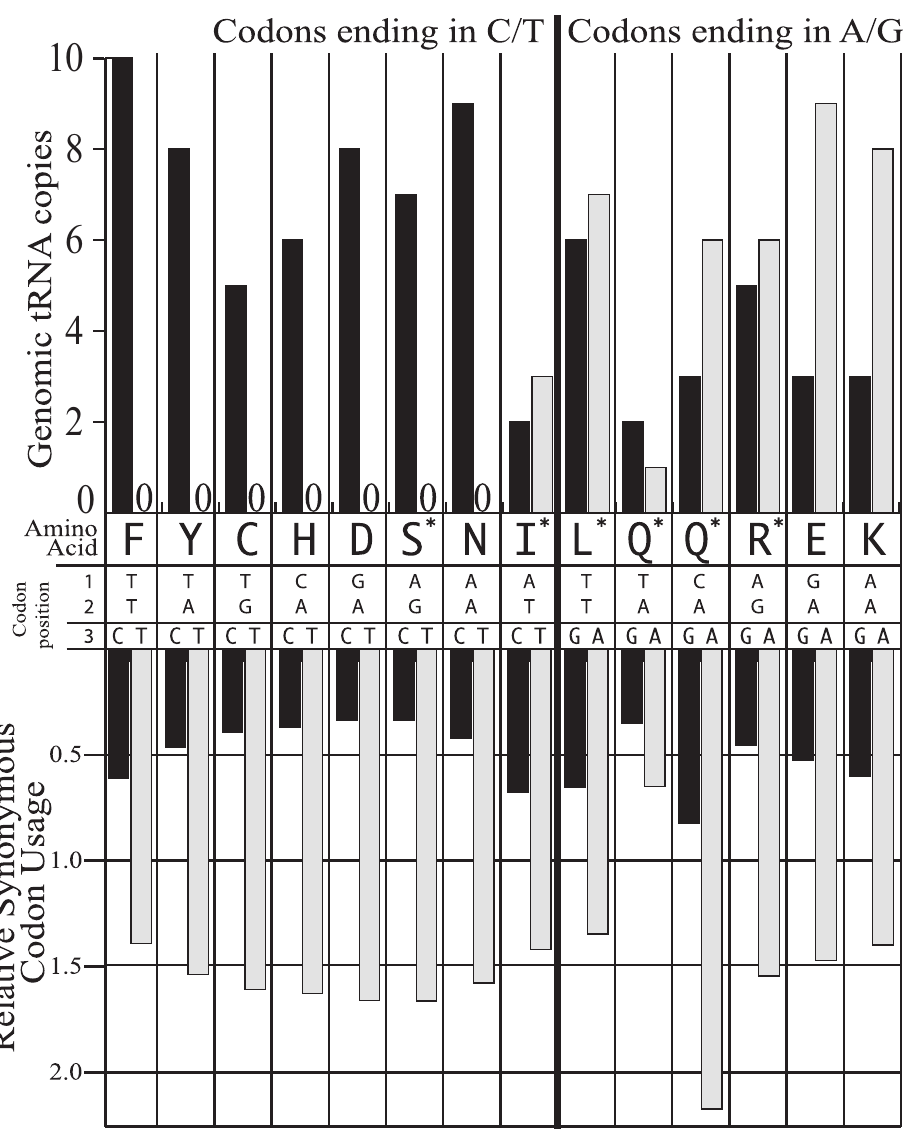
Fig 6. Comparison of codons in transcripts versus tRNA count in genomic assembly. The relative synonymous codon usage (RSCU) for 28 codons in 1,466 transcripts are shown as a bar graph in the bottom portion, while the top portion shows number of complementary tRNA found in the genome survey. The black bars are used for codons ending in G or C, while the grey bars are for codons ending in A or U. The codons were sorted based on third positions ending in C or U (left portion of figure) when compared with those ending in G or A (right portion). Due to redundancy in the genetic code some amino acids have between one and six possible codons. The 28 codons shown include the 16 third position informative codons ending in C or T and A or G, or amino acids with just two codons. For comparison an additional 12 codons for amino acids with three to six codons are shown and indicated with an asterisk. The RSCU values for likely glutamine codons (UAG, UAA and CAU, CAG) sum to four while phenylalanine with two codons would sum to two and serine to six. All of the codons that were synonymous at third positions and AUG, AUA, UGG and UGA were